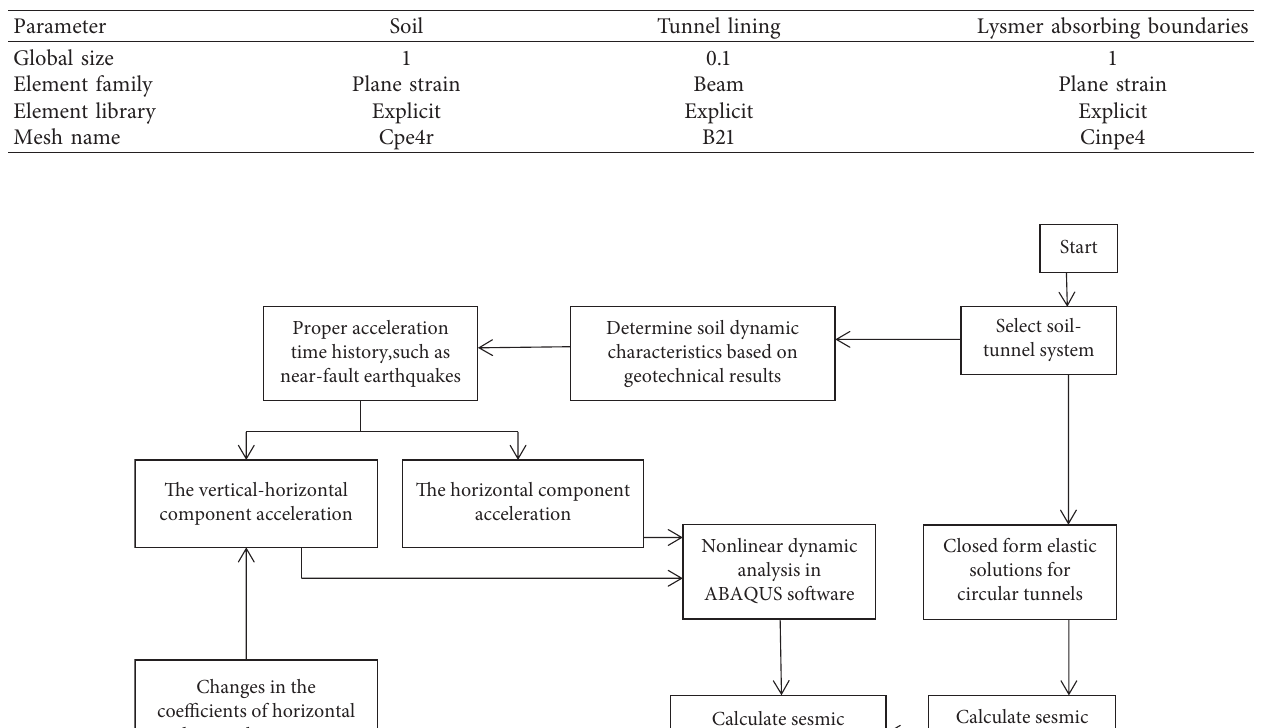
Table 12: Default parameters of tunnel lining and soil in the finite element model.